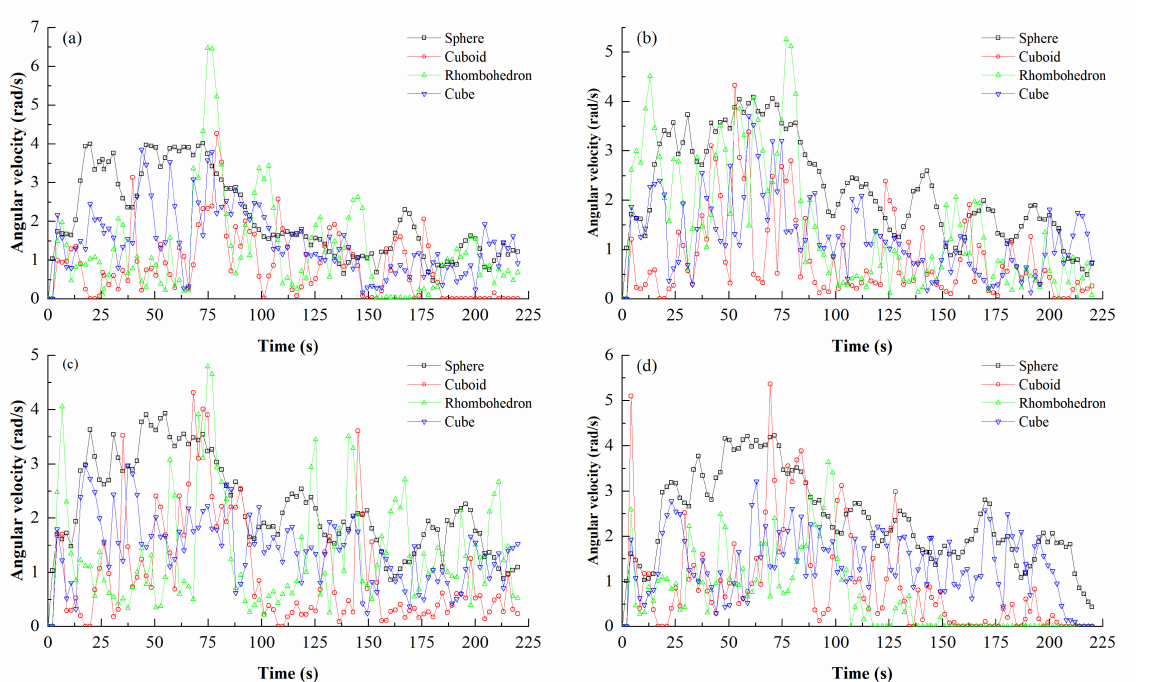
Figure 10. Influence of boulder shape on angular velocity under different density conditions, ( a ) ρ = 1200 kg/m 3 , ( b ) ρ = 1500 kg/m 3 , ( c ) ρ = 1800 kg/m 3 , and ( d ) ρ = 2100 kg/m 3